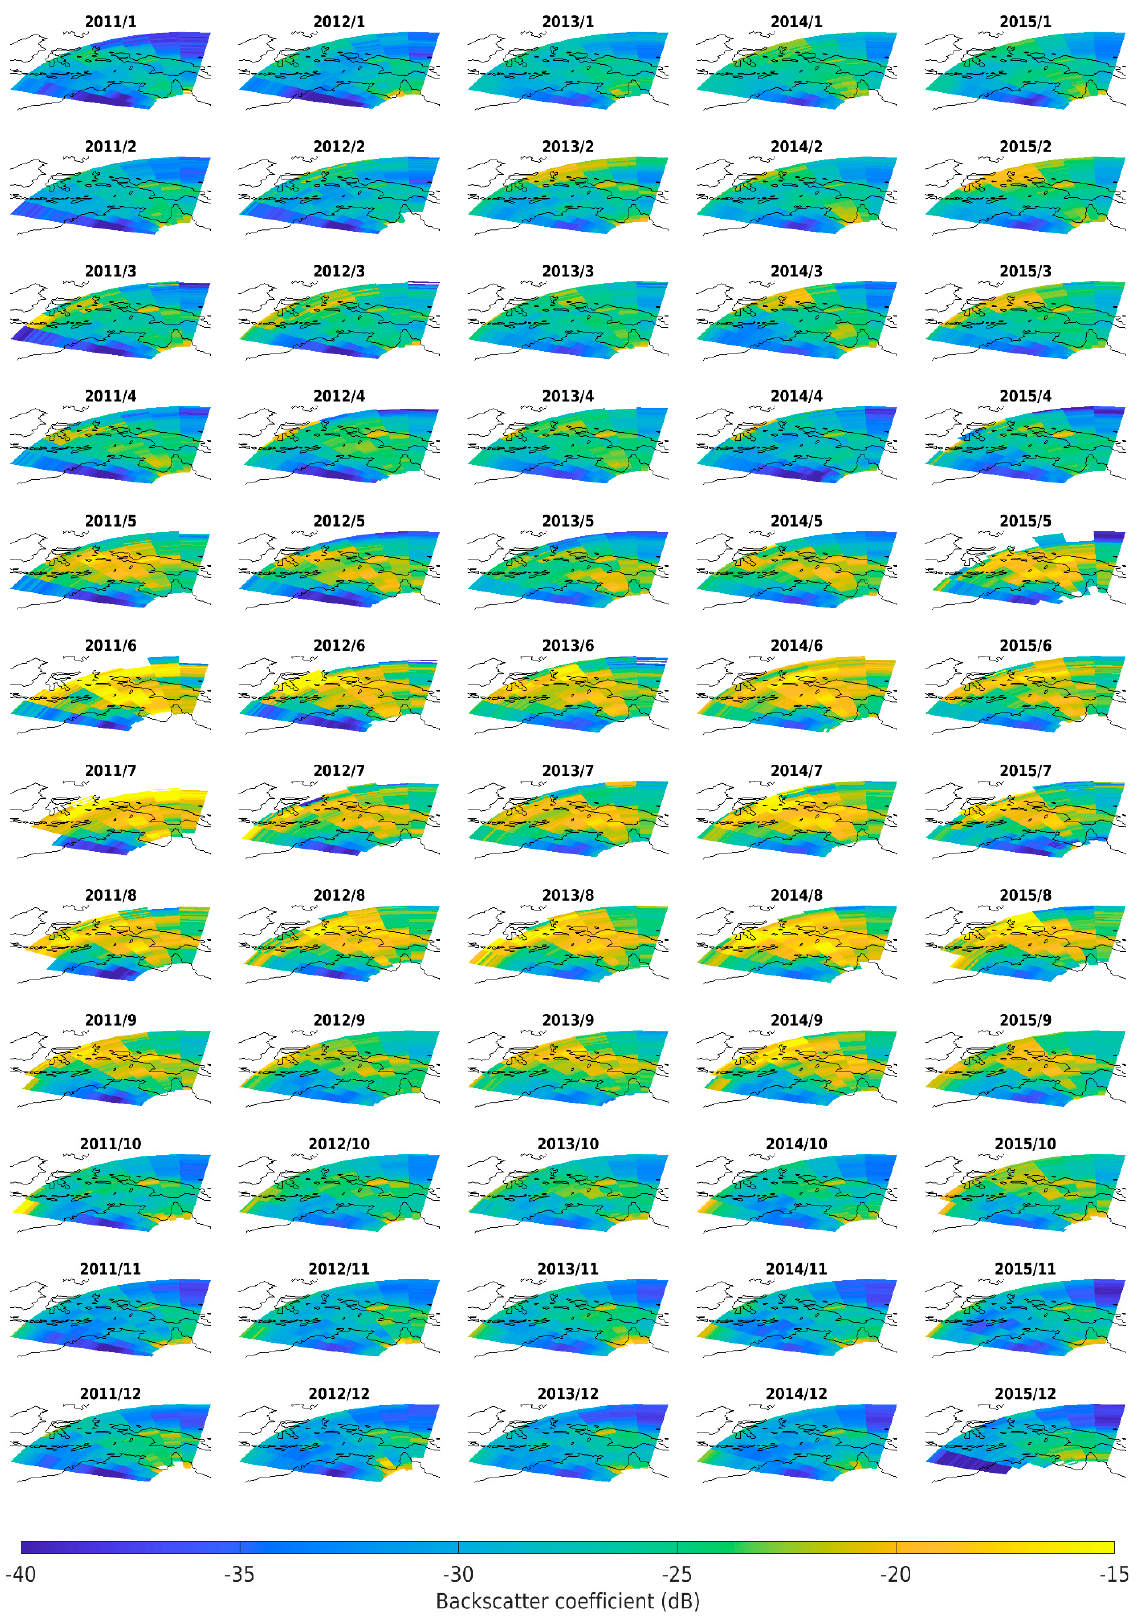
Figure 4. Monthly mean backscatter coefficients for LO over a 5 year period from January 2011 ( top left plot ) through to December 2015 ( bottom right plot ).